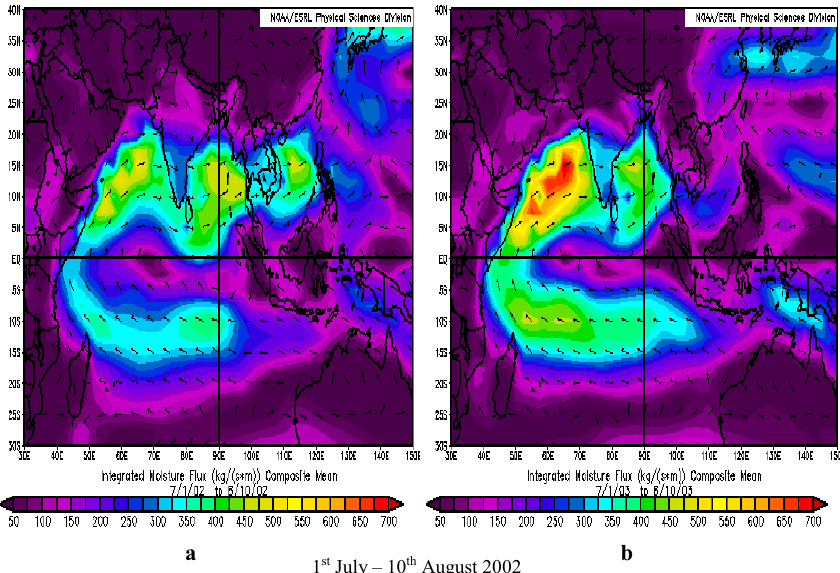
a b Fig. 9. Analysis of different parameters during 1 July–10 August for the years 2002–2003. (a) , (b) Integrated moisture flux (1000–300hPa) 2002 and 2003, Fig. (9): Analysis of different parameters during 1 July - 10 August for the years 2002-2003. a, b: Integrated Moisture Flux (1000-300hPa) 2002 and 2003 respectively.